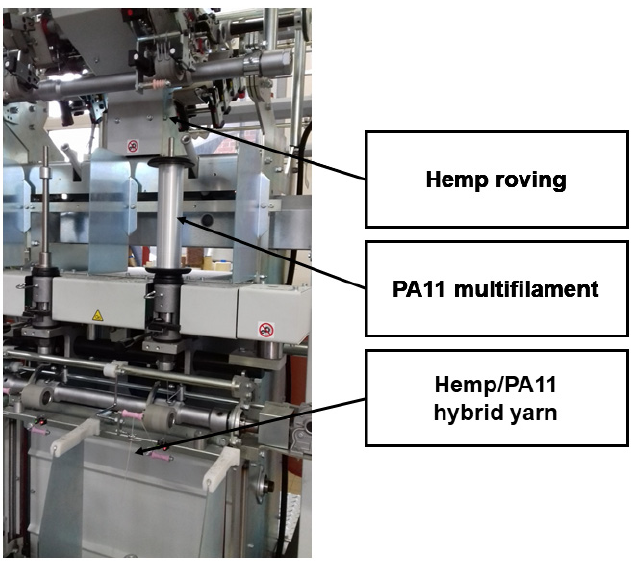
Figure 1. The wrapping